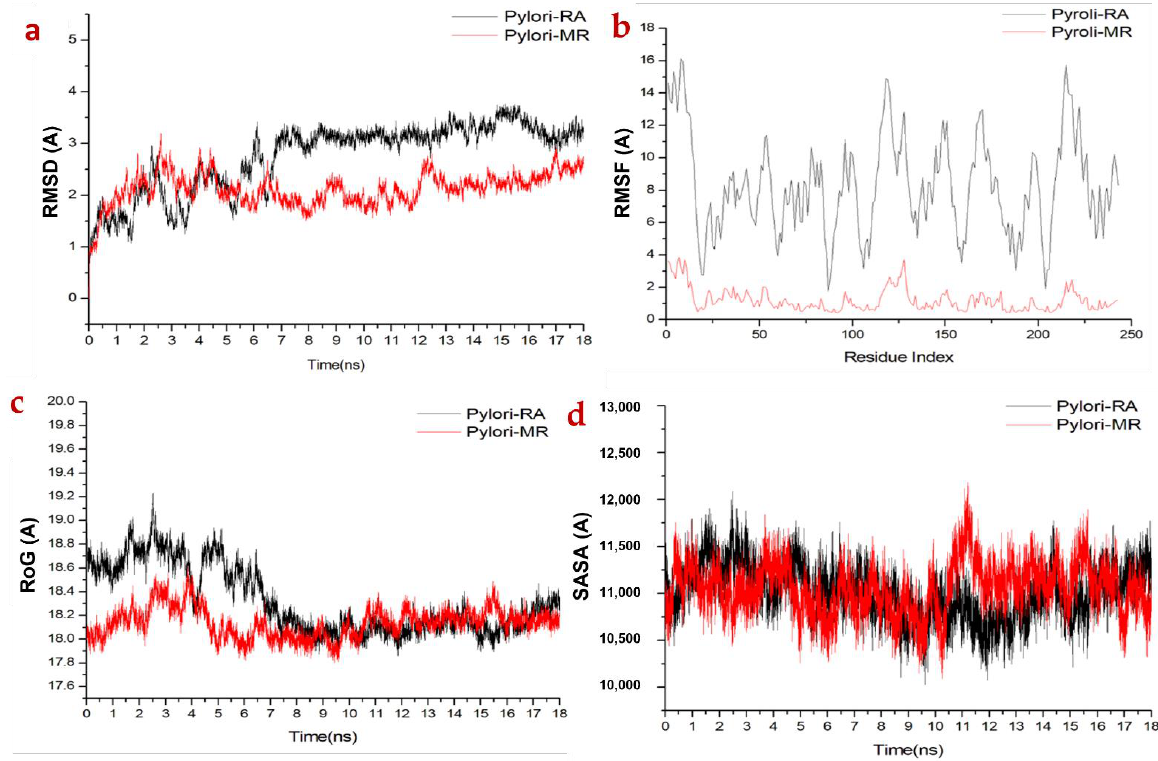
Figure 5. ( a ) RMSD of C α atoms of the protein backbone atoms; ( b ) RMSF of each residue of the protein backbone C α atoms; ( c ) ROG of C α atoms of protein residues; ( d ) solvent accessible surface area (SASA) of the backbone atoms relative to the starting.